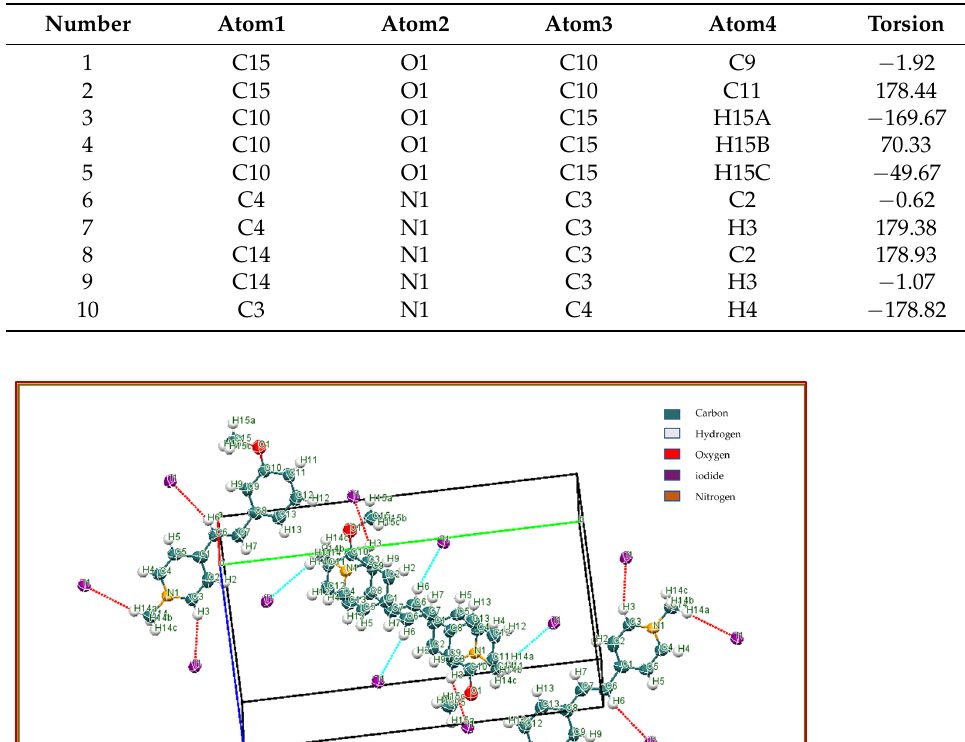
Table 3. Selected torsion angle for MMPI crystal.